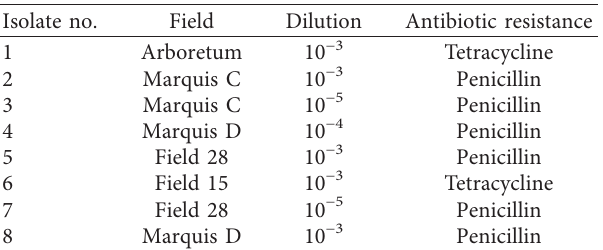
Table 3: Description of antibiotic-resistant isolates from the Pierce Farm.